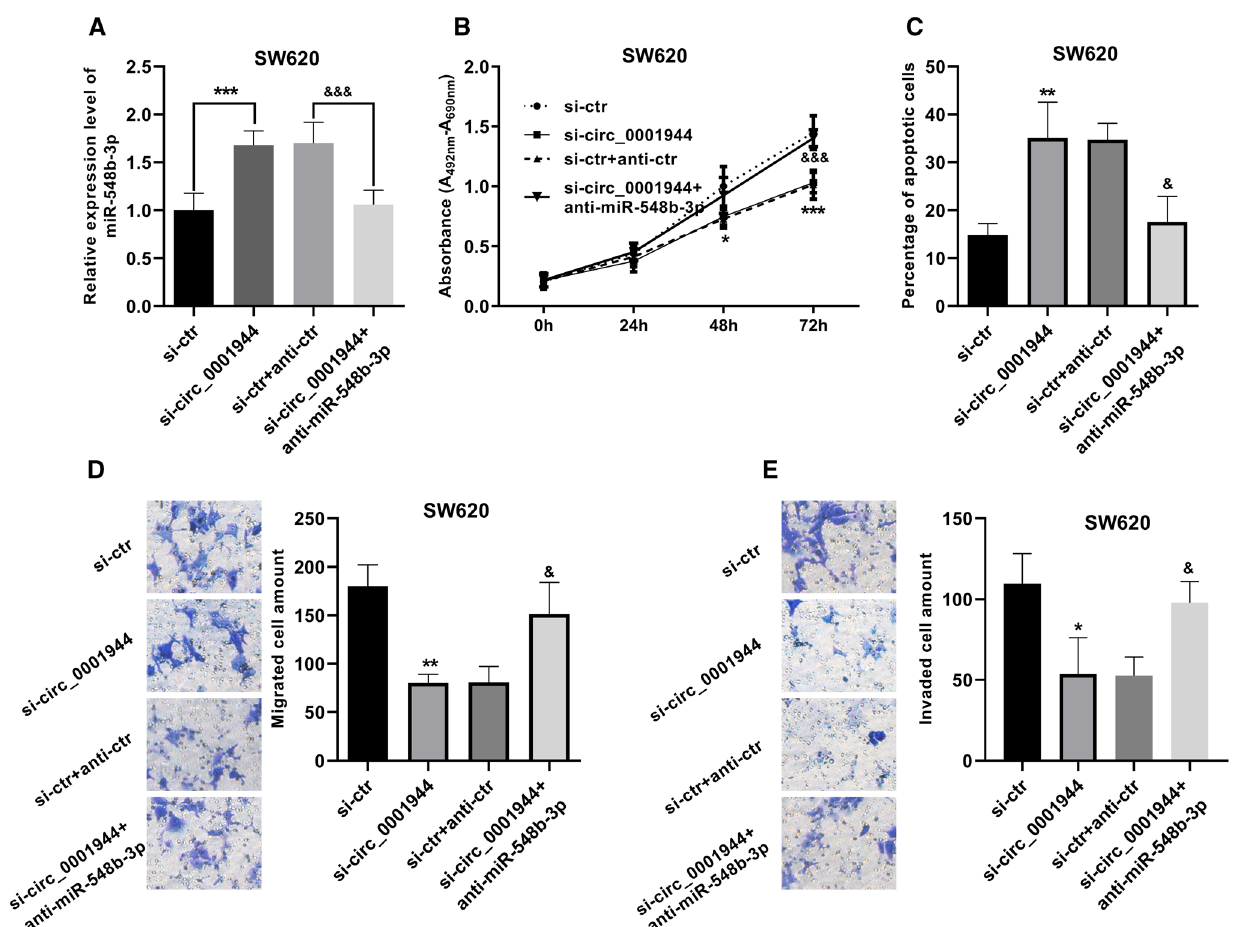
Fig. 4 miRNA-548b-3p knockdown deteriorated hsa_circ_0001944-caused proliferation inhibition, migration inhibition, invasion inhibition, and apoptosis induction. A The transfection efficiency was determined by qRT-PCR. B Cell proliferation was evaluated by XTT assay. C Quan- titative statistical chart of the apoptotic cells. D , E Numbers of migrating and invaded cells were determined using Transwell assay. * P < 0.05, ** P < 0.01, *** P < 0.001 (vs si-ctr). & P < 0.05, &&& P < 0.001(vs si-ctr +